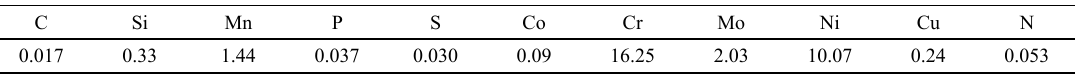
Table 1. Chemical composition AISI 316L